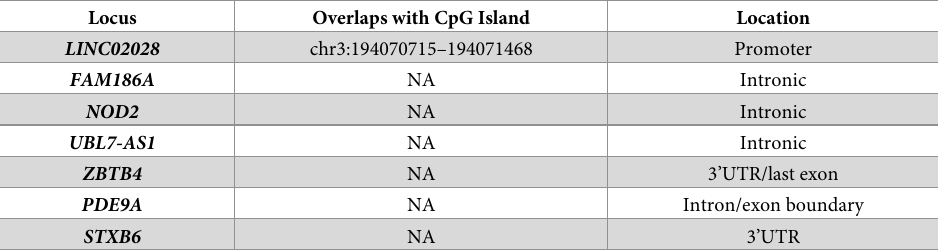
Table 4. Functional information for the isPTB